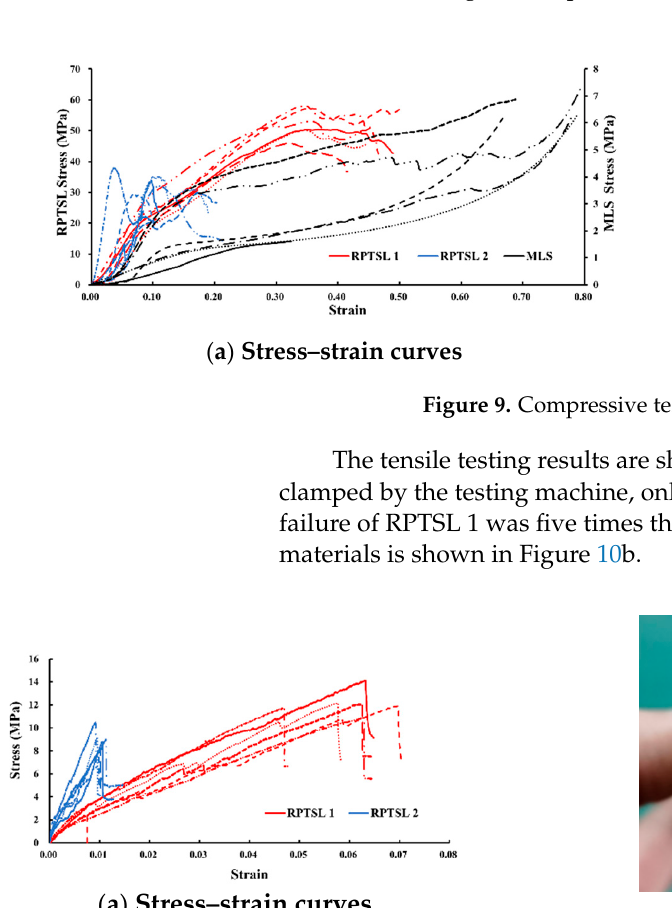
Figure 10. Tensile testing result.